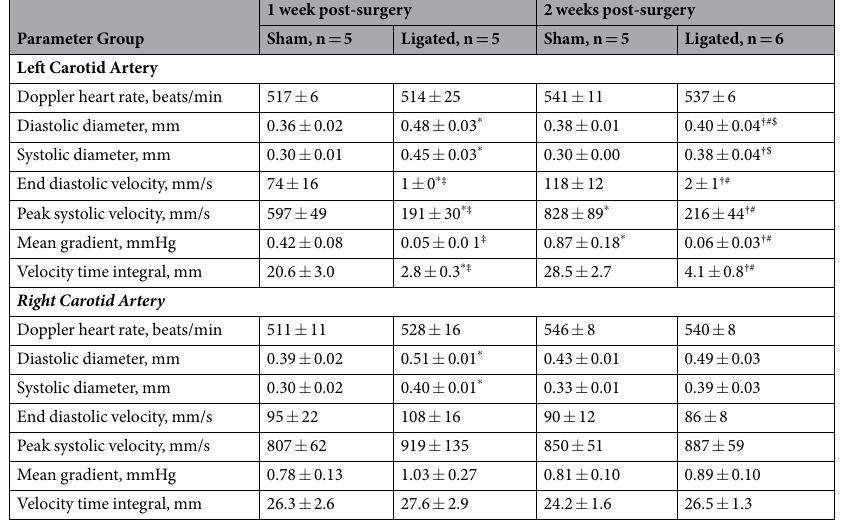
Table 1. Ligation procedure significantly changed blood flow profiles of carotid arteries in FVB mice over a 2 week time period. Parameters are shown as mean ± SEM. * p < 0.05 vs. Sham, 1 week. † p < 0.05 vs. Sham, 2 weeks. ‡ p < 0.05 vs. Ligated RCA, 1 week. # p < 0.05 vs. Ligated RCA, 2 weeks. $ p < 0.05 vs. Ligated LCA, 1 week. n, Number per